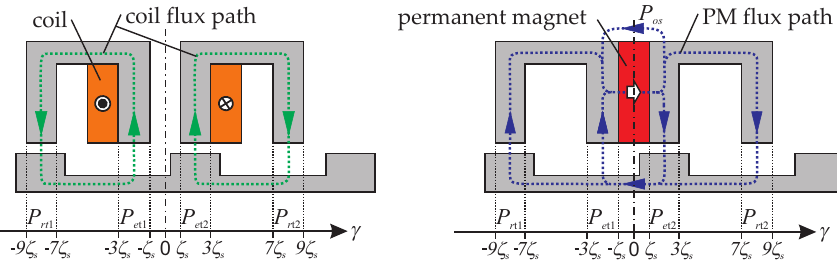
Figure 3. Unrolled cross-sectional part of the flux-switching motor, with the field lines created by the stator coil current ( left ) and one permanent magnet placed between the stator teeth ( right